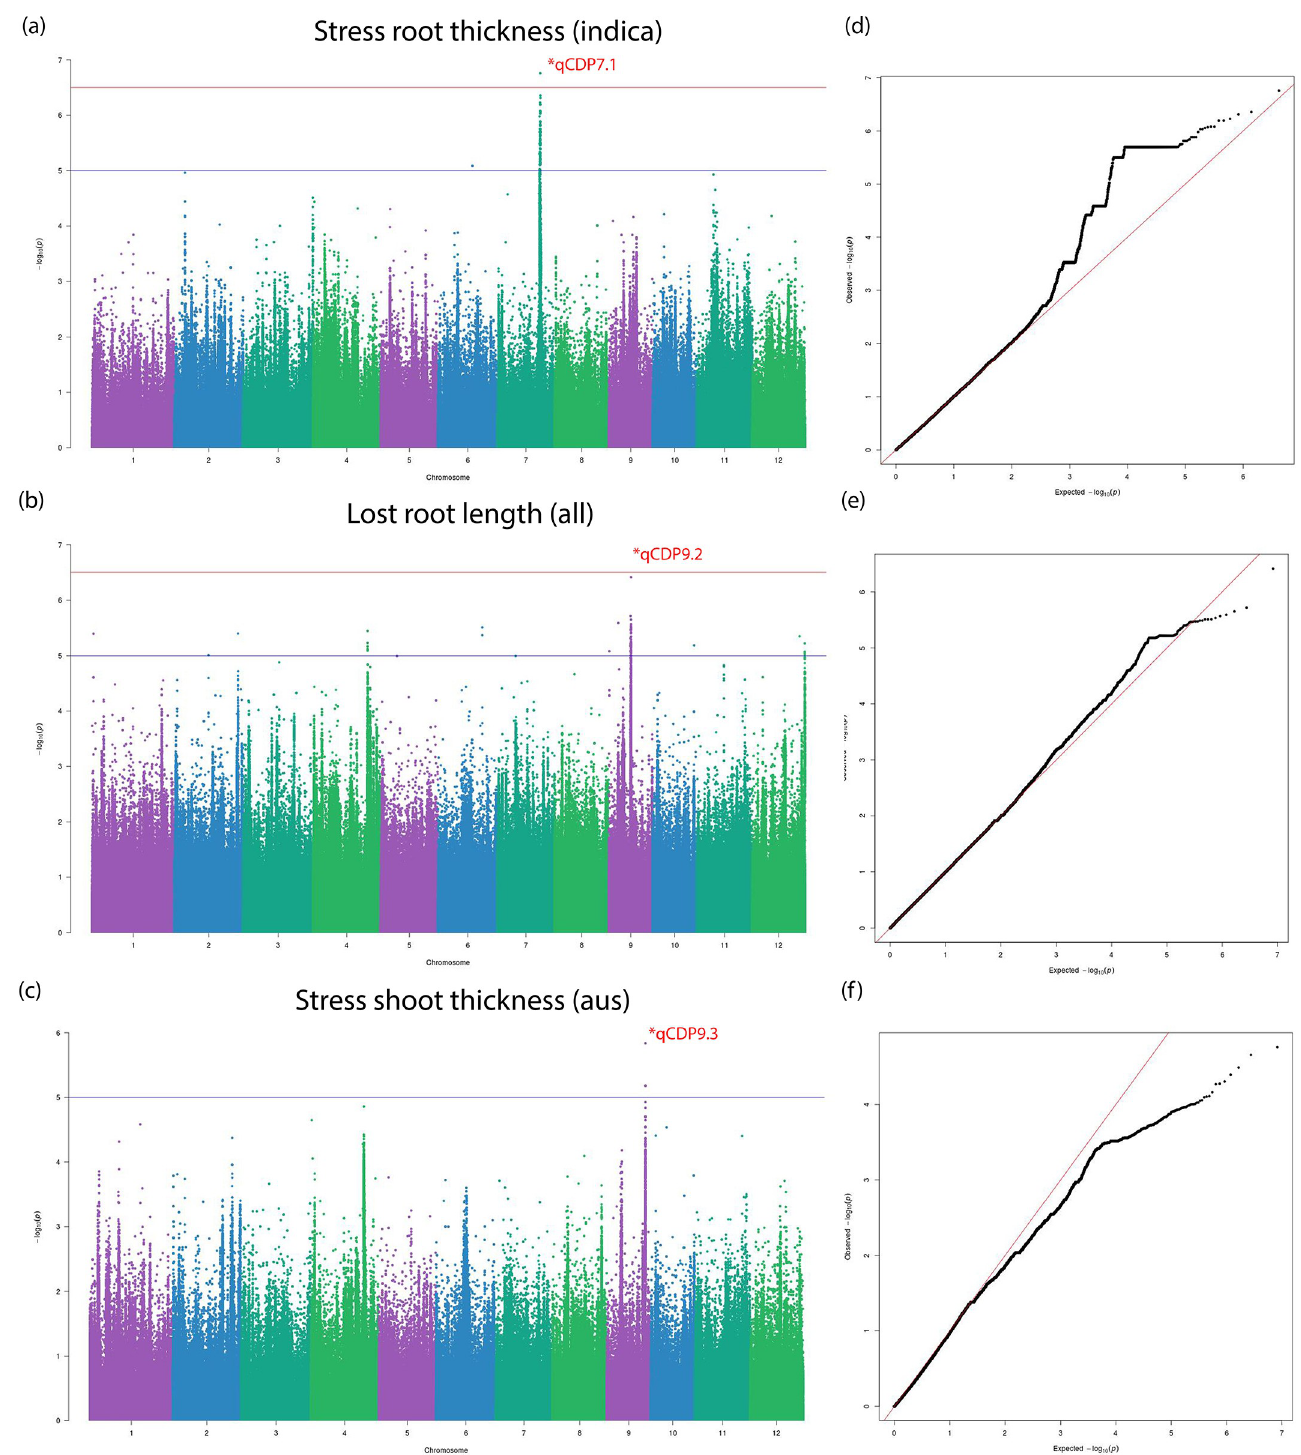
Fig 7. Manhattan and Q-Q plots for qCDP7.1, qCDP9.1 and qCDP9.3. Horizontal red and blue lines show the significant and suggestive thresholds respectively. Vertical black dotted lines show the locations of the three QTLs in the three Manhattan plots.